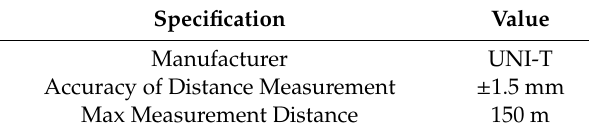
Table 5. The specifications of the UT390G laser rangefinder.